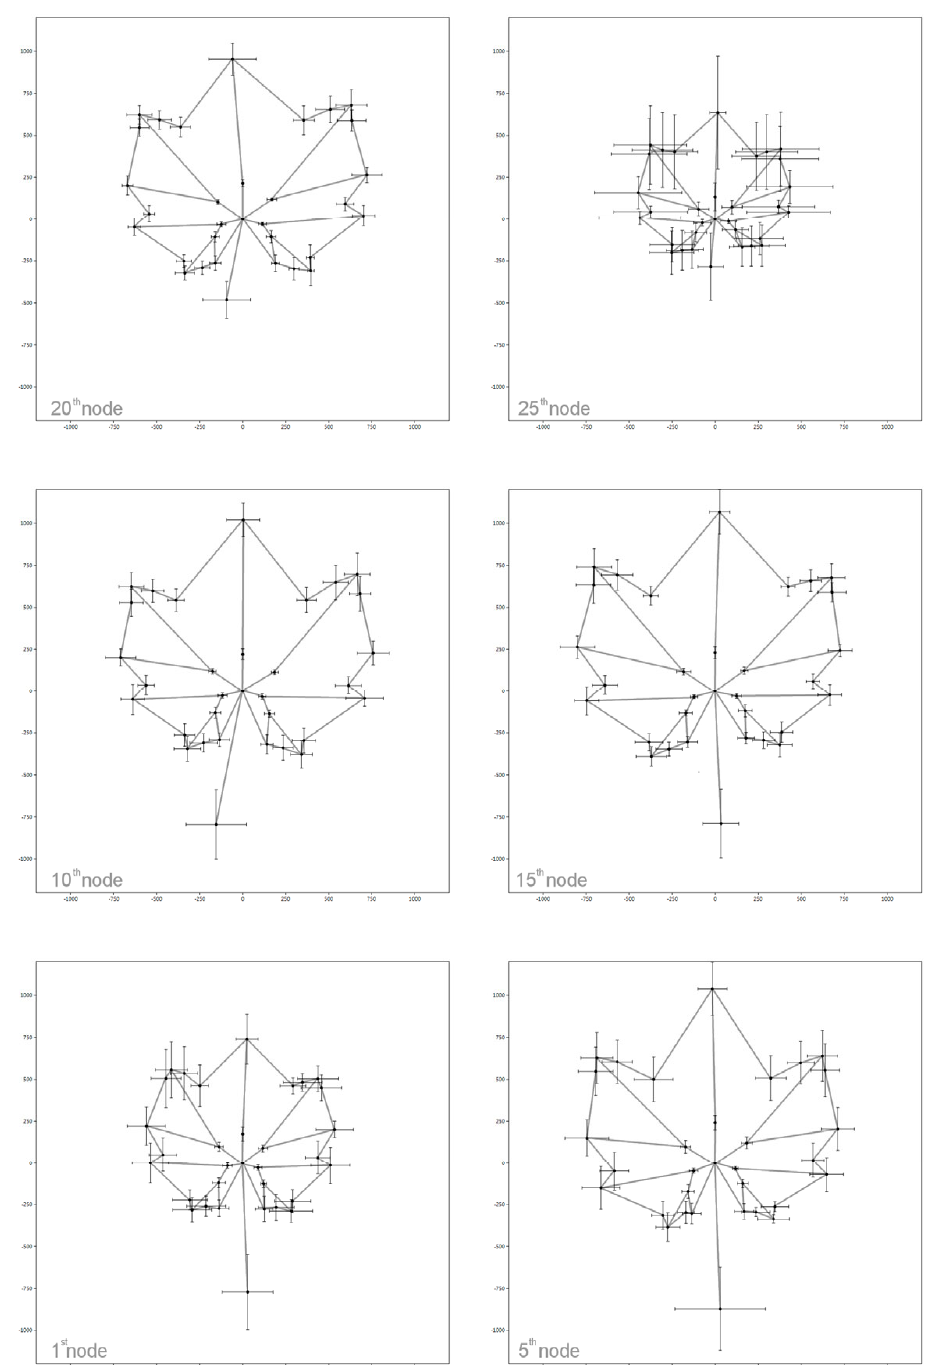
Figure 6. Grapevine ( Vitis vinifera L.) leaves show noticeable variability along the shoot axis. This Figure 6. Mean and standard deviation of the x,y coordinates of 32 landmarks on the leaves along phenomenon was investigated according to 52 morphometric traits and those coefficients of variability the shoot axis on the 1st, 5th, 10th, 15th, 20th, and 25th nodes (Bodor et. al, [78] with permission (C v ) at each node in Bodor et al. [78] (with permission from the publisher), who found that samples from the publisher). collected from the 11th node have the lowest variability among 10